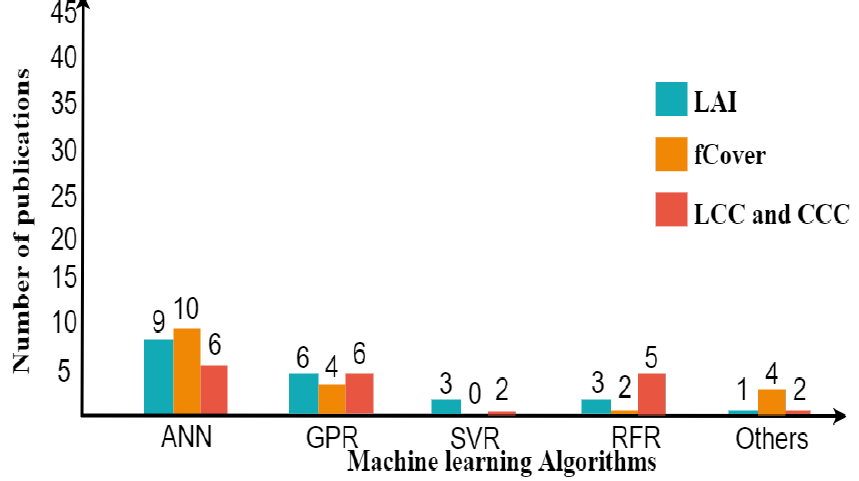
Figure 7. Bar chart of the most contributed machine learning methods used in a hybrid